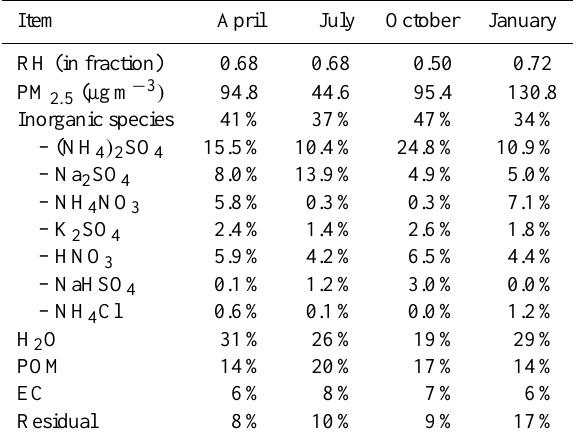
Table 6. Ambient RH condition and the corresponding optical prop- erties of PM 0 . 5 − 20